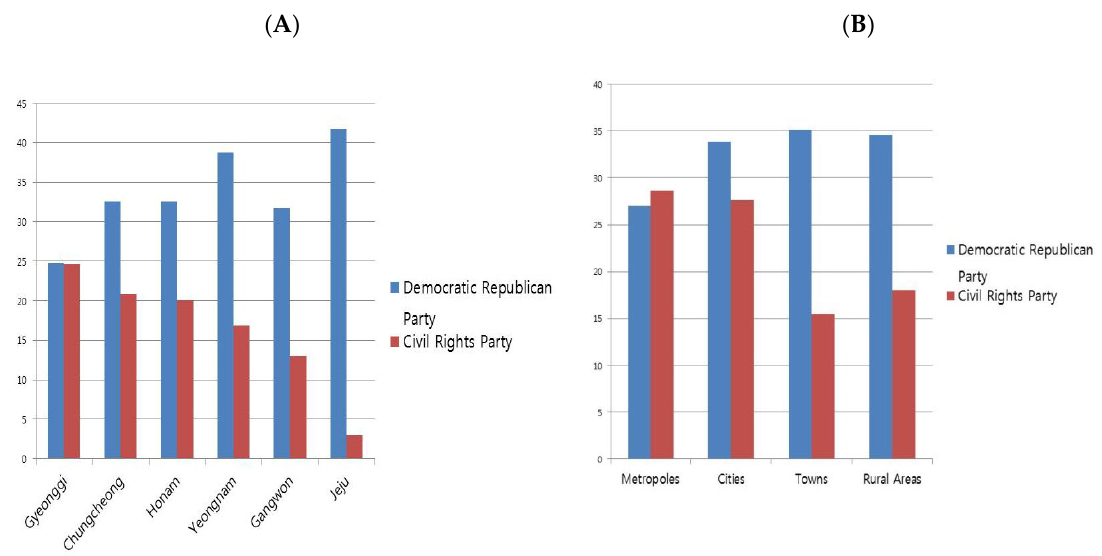
Figure 1. Voting Shares in the Sixth General Election, November 1963. ( A ) Voting Shares by Province. ( B ) Voting Shares by Urban/Rural Division.